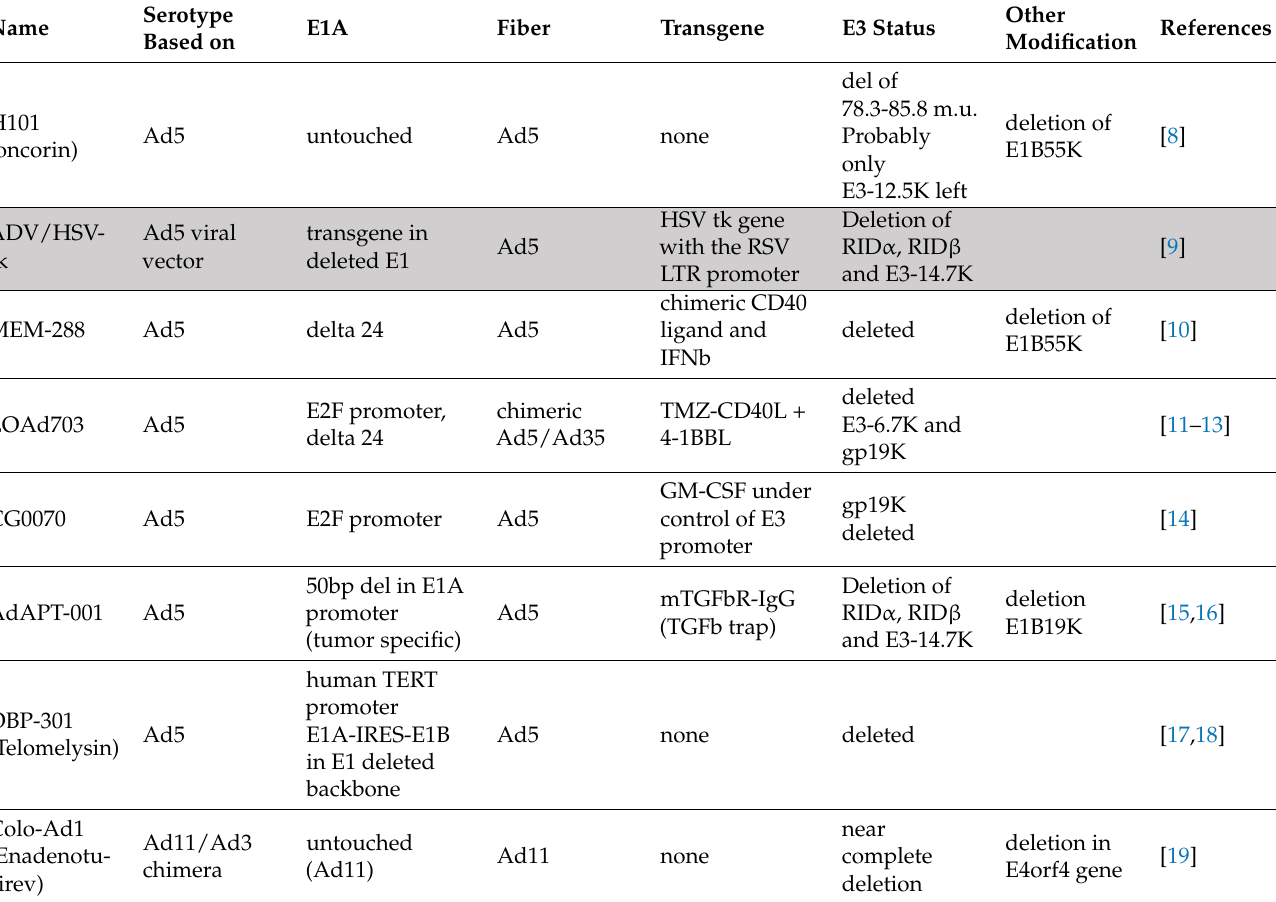
Table 1. Adenoviral vectors currently in clinical trials for cancer therapy. Replication defective viruses that are used for gene delivery only are shaded in